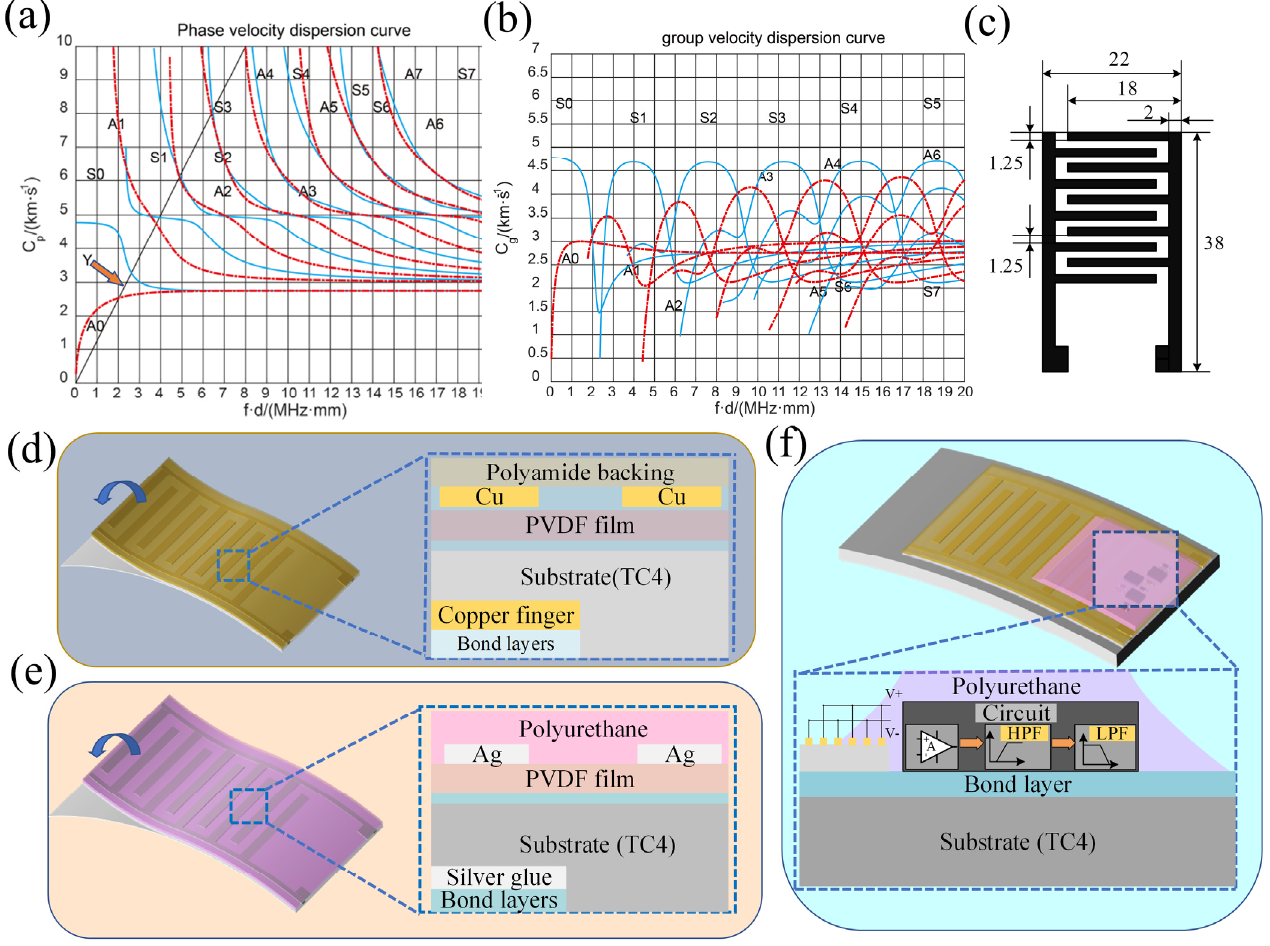
Figure 1. ( a ) Phase Velocity Dispersion Curve of Titanium Alloy Plate. ( b ) Group velocity dispersion curve of titanium alloy plate. ( c ) Electrode pattern parameters of IDT. ( d ) Structure of flexible PCB-IDT. ( e ) Structure of IDT made by screen printing. ( f ) Conceptual diagram of IDT receiving circuit.